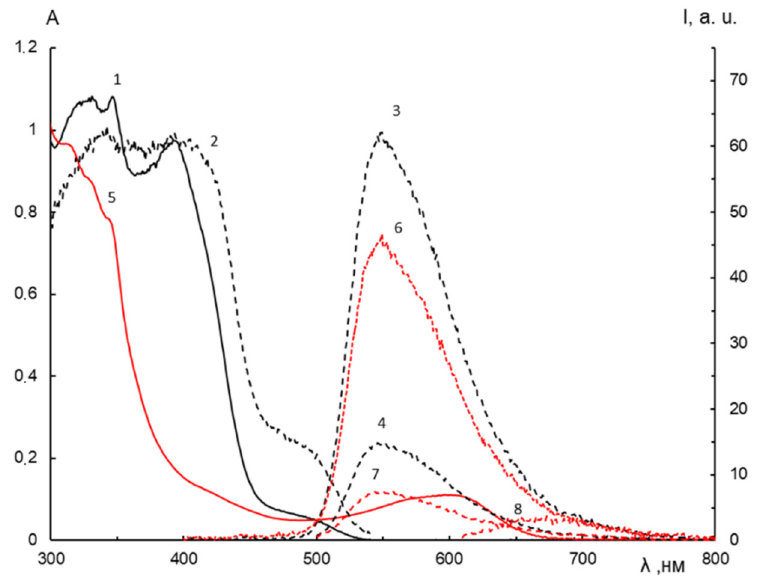
Figure 5. Absorption spectra (1, 5), fluorescence excitation spectrum at λ reg = 550 nm (2) and fluorescence spectra at λ ex = 390 nm (3, 6), 490 nm (4, 7) and 600 nm (8) of compound 1 before (1–4) and after (5–8) UV irradiation by the external source (5–8) in the mixed solvent solution.